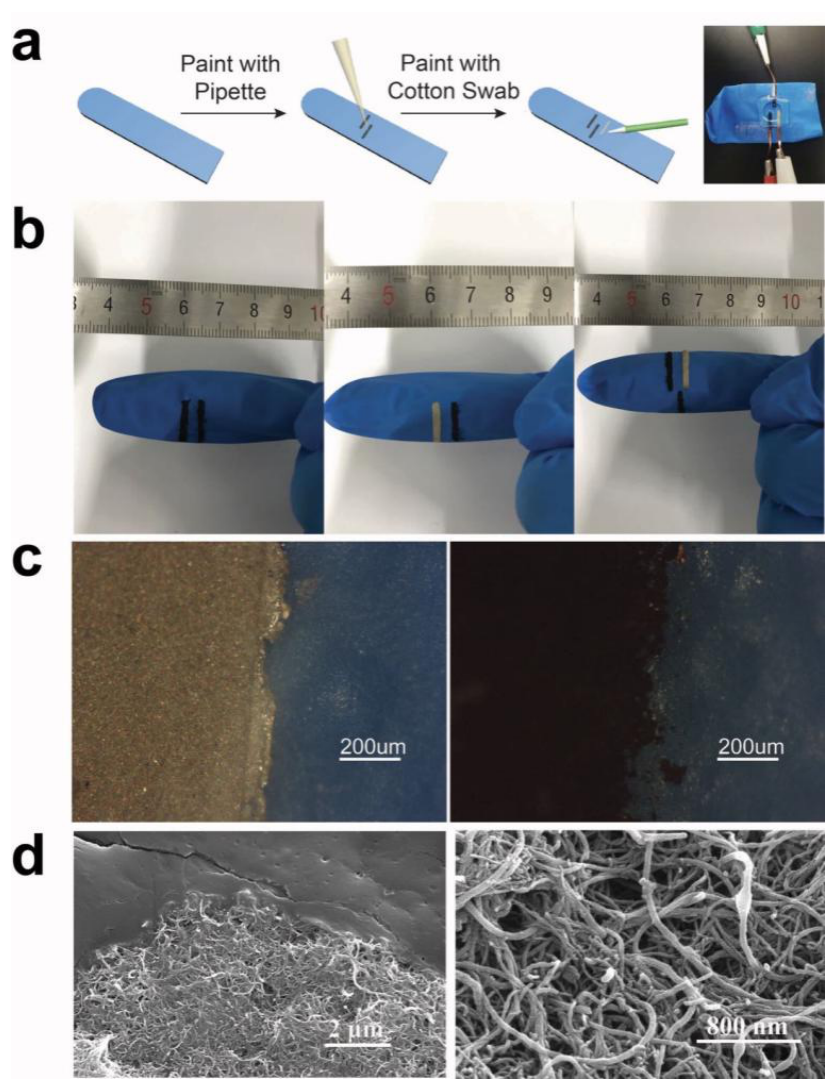
Figure 1. Optical characterization of the glove-based biosensor. ( a ) Schematic illustration of the fabrication process of the sensor and the connection method. From left to right: Blank glove; Depositing CNT solution onto the glove surface with auto pipettes; painting the Ag/AgCl electrode with cotton swabs; connecting electrodes with potentiostat with copper wires. ( b ) Camera images of the CNT-based glove biosensors. Left : a sensor based on two CNT electrodes. Middle : a sensor based on a CNT and an Ag/AgCl electrode based sensor. Right : a sensor based on two CNT electrodes and an Ag/AgCl electrode. ( c ) Optical image of the interface between CNT electrode and the substrate ( left ) and magnification of CNT electrode ( right ). ( d ) SEM images of the CNT electrode. Left : Interface between the CNT electrode and the glove substrate. Right : the surface of CNT